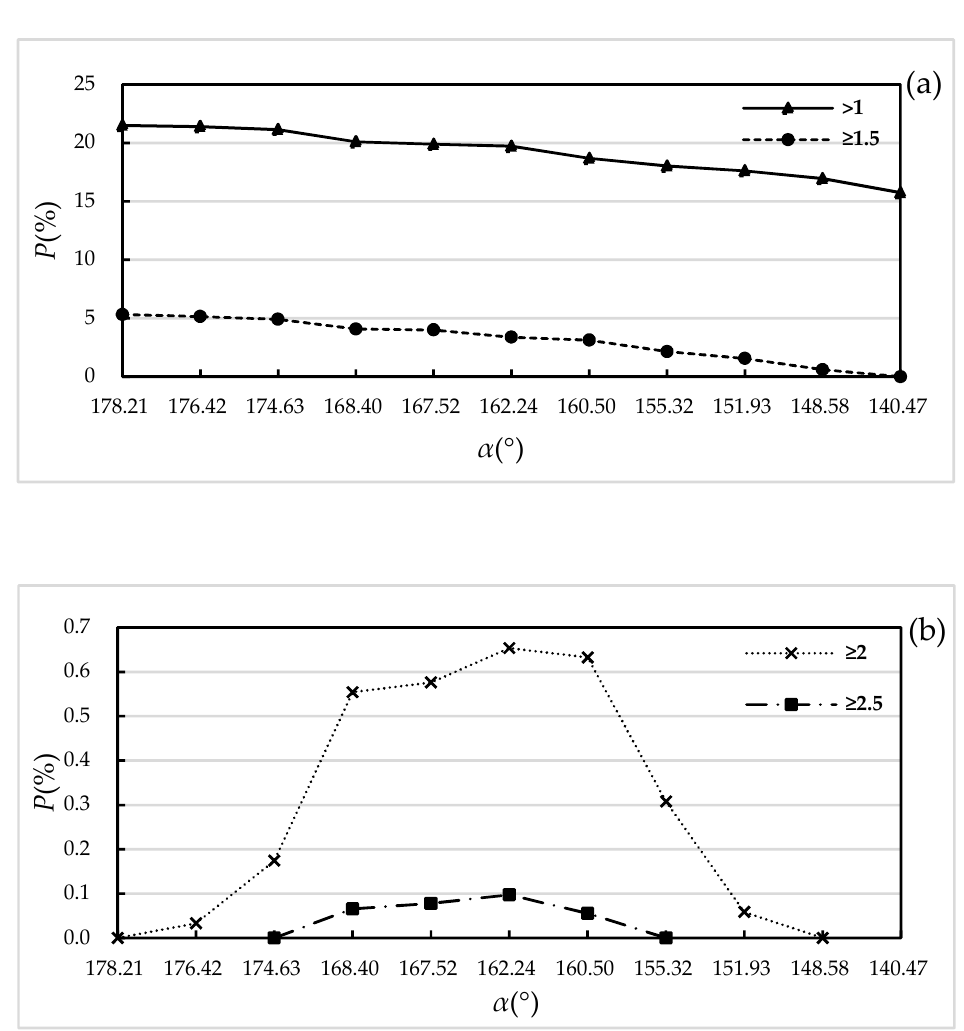
Figure 5. Level-frequency statistical diagrams of wave amplitude changes under different angles α : ( a ) A max /A 0 > 1 and A max /A 0 ≥ 1.5; ( b ) A max /A 0 ≥ 2 and A max /A 0 ≥